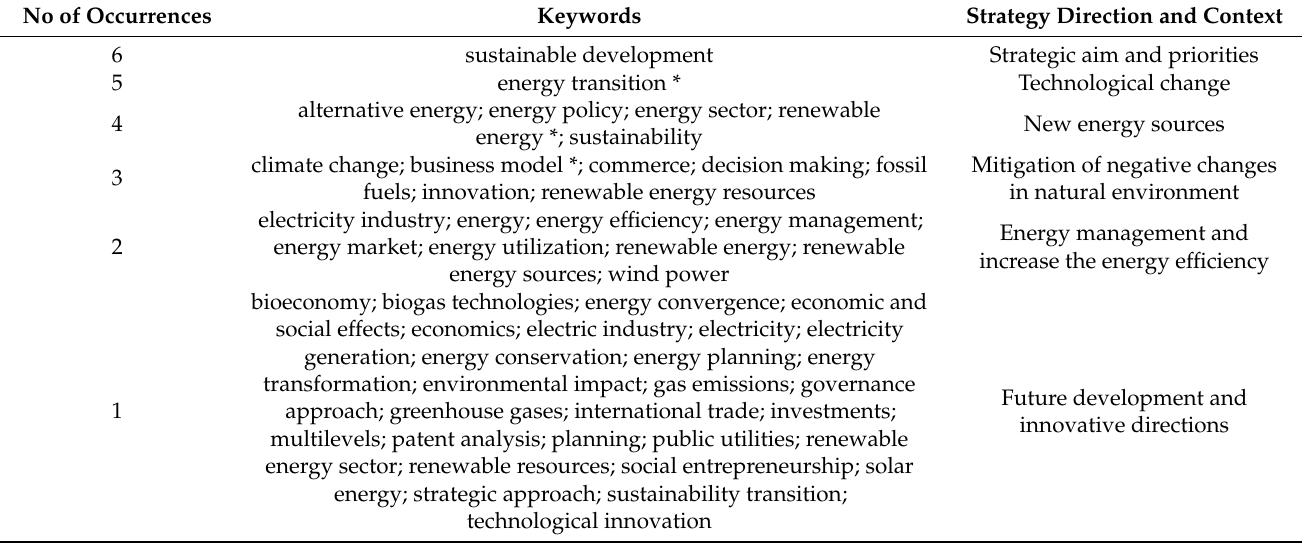
Table 11. Common and different keywords among analyzed Queries 15, 18, 19, 20, 21, and